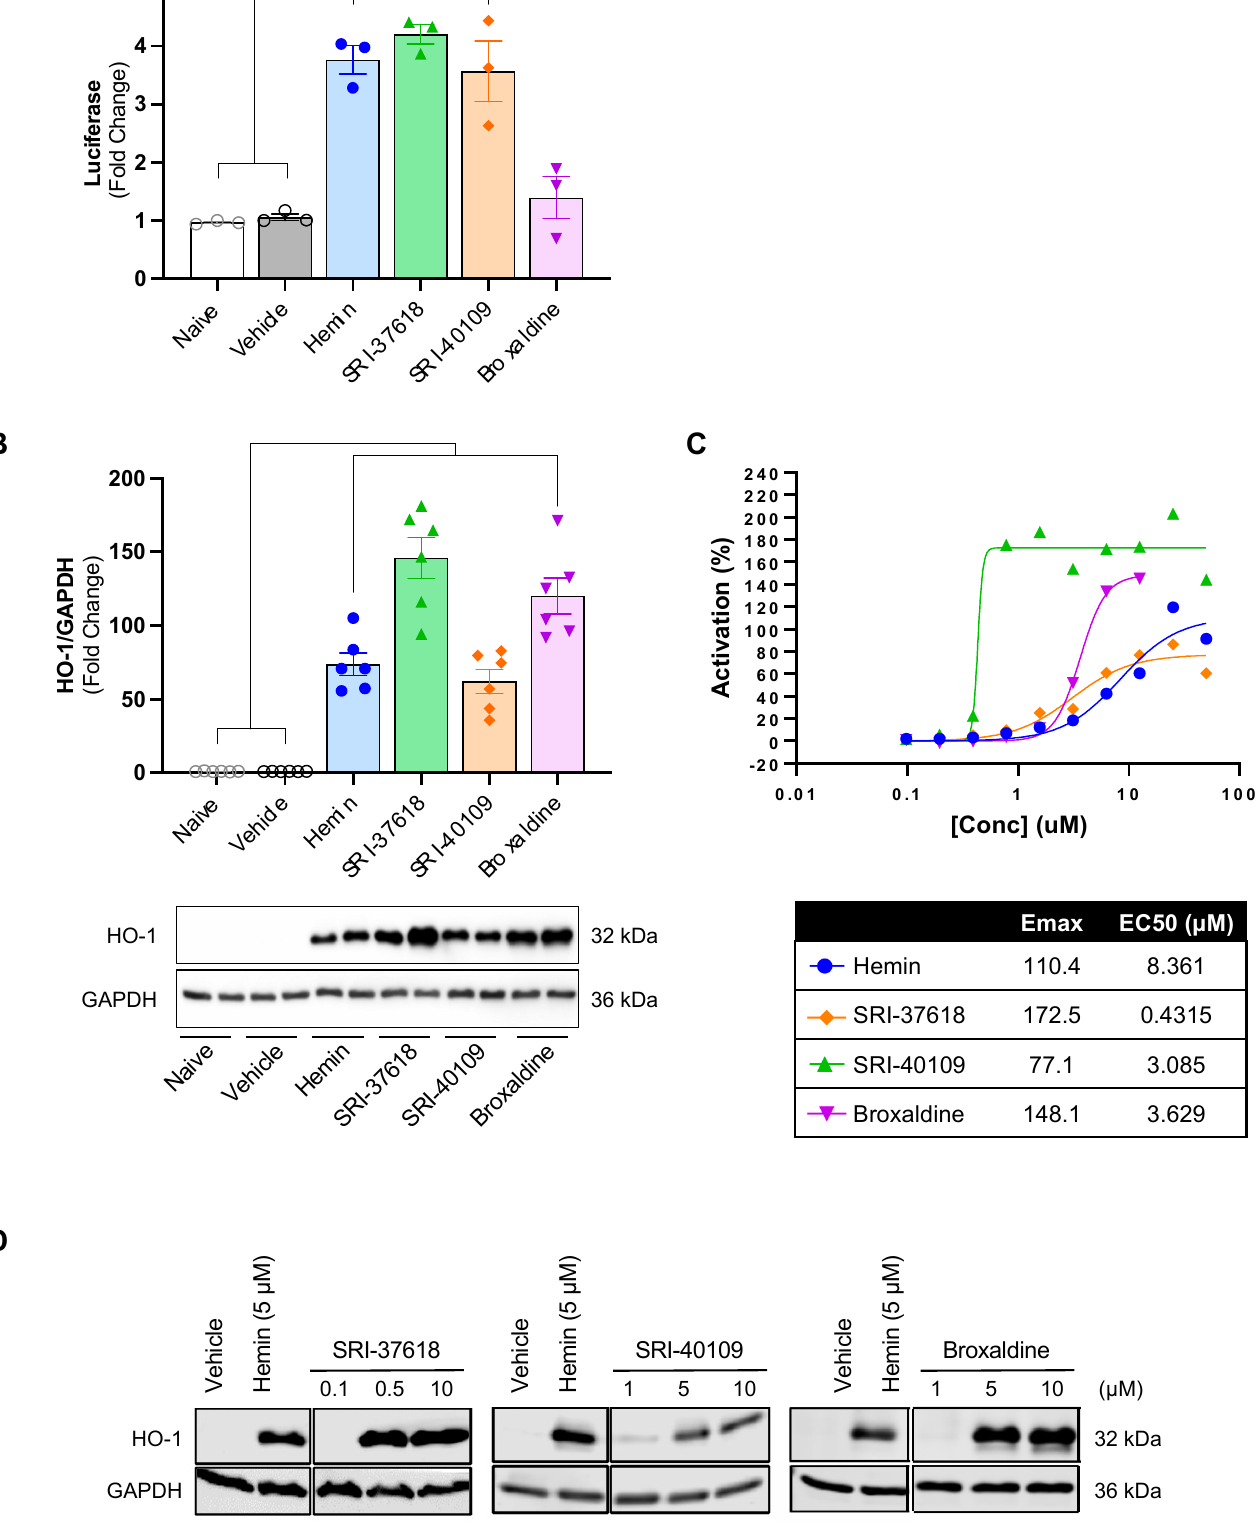
Figure 3. ( A ) Luciferase activity induced in 4.5 kb + 220 bp HO-1-Luc cells by small molecules normalized to baseline luciferase signal in naïve, untreated cells. DMSO and hemin are included as vehicle and positive controls. ( B ) Densitometry of Western blot of 4.5 kb + 220 bp HO-1-Luc cells for HO-1 and loading control GAPDH under the same experimental conditions as luciferase assay.